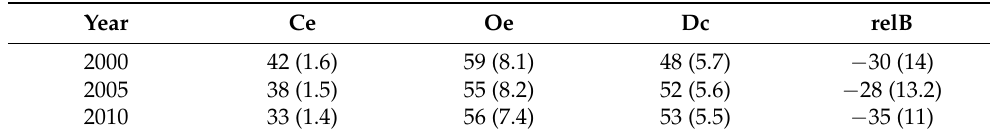
Table 11. Estimated accuracy (expressed as %) for the global urban product in each validation year. The standard deviation is shown in